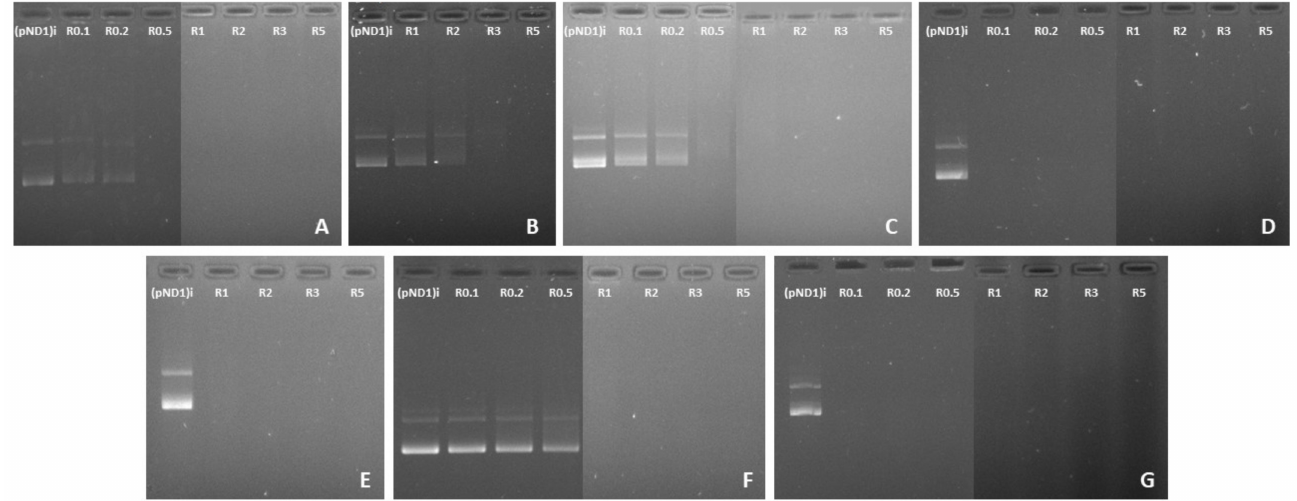
Figure 1. Analysis of pND1 complexation capacity of CpMTP/pND1 ( A ); WRAP1/pND1 ( B ); WRAP5/pND1 ( C ); (KH)9/pND1 ( D ); MTS-WRAP1/pND1 ( E ); MTS-WRAP5/pND1 ( F ) and MTS-(KH)9/pND1 ( G ) complexes at various N/P ratios, investigated by agarose gel electrophoresis. The samples were loaded at the application site at the upper end of the image (anode) and migrated then to the lower end